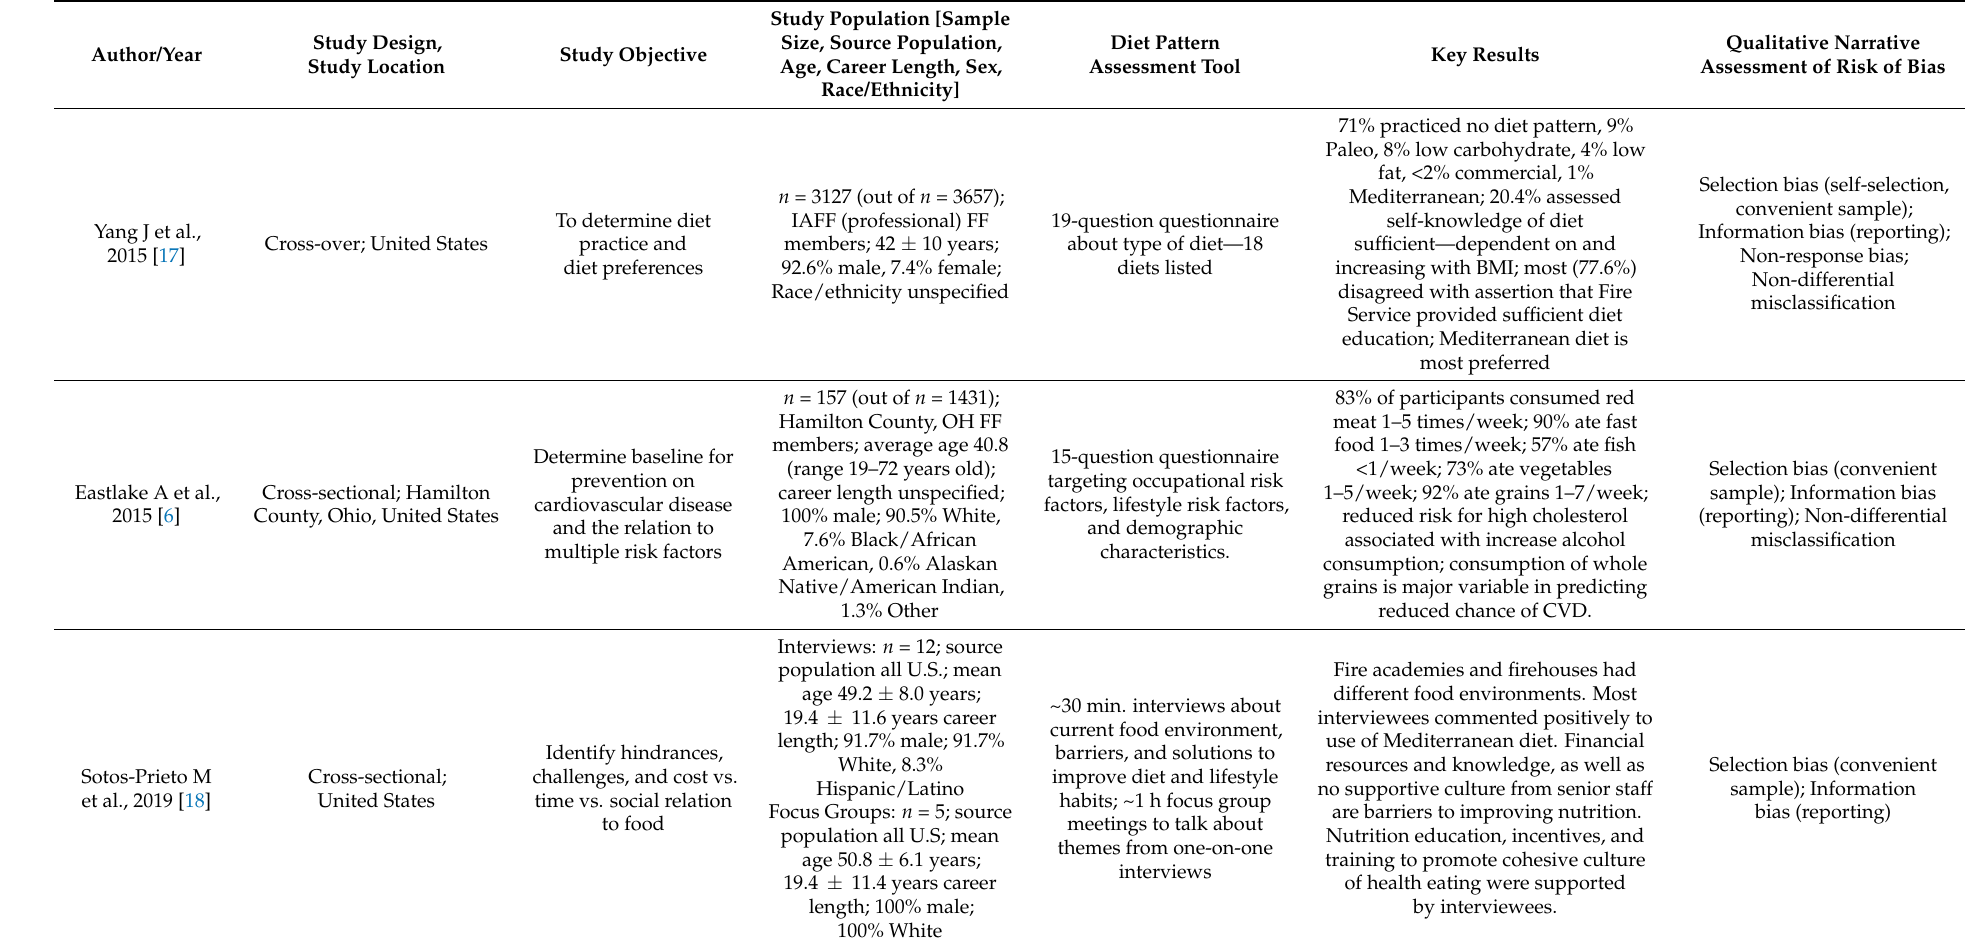
Table 1. Observational